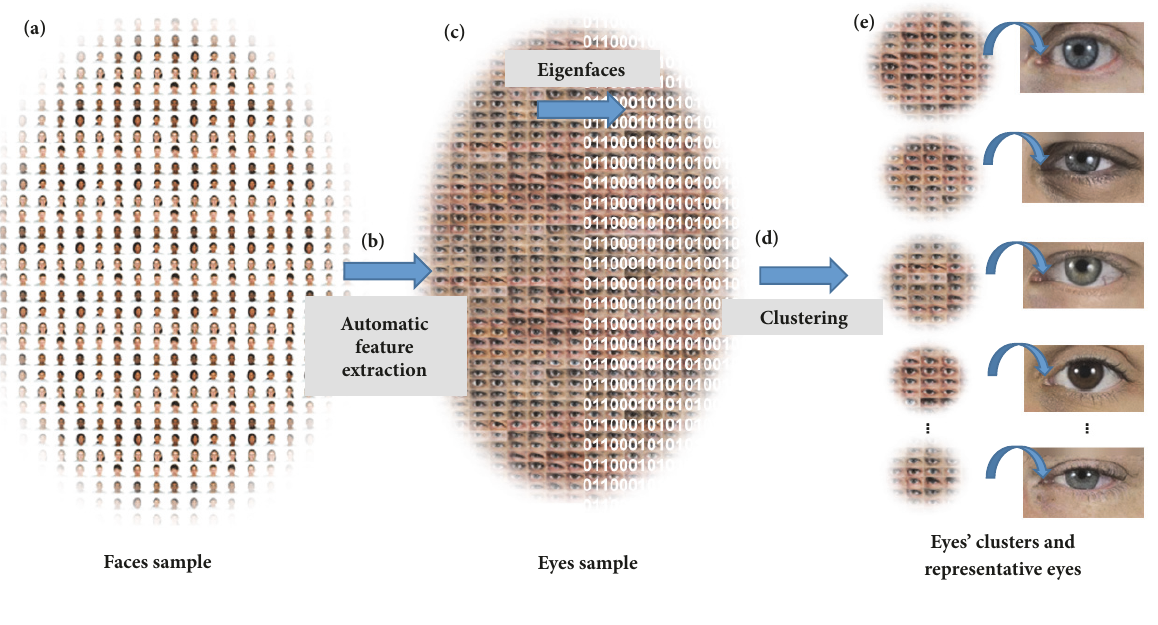
Figure 4: Process to establish the alleles of each gene. (a) A set of 93 images of faces is analysed. (b) Individual images of the facial features of each face are automatically extracted. (c) Eigenfaces are used to characterize each facial feature by its global appearance. (d) The facial features are grouped by appearance using their eigenvalues. (e) The features closest to the centre of their clusters will be used as alleles of the corresponding gene in the chromosomes of the